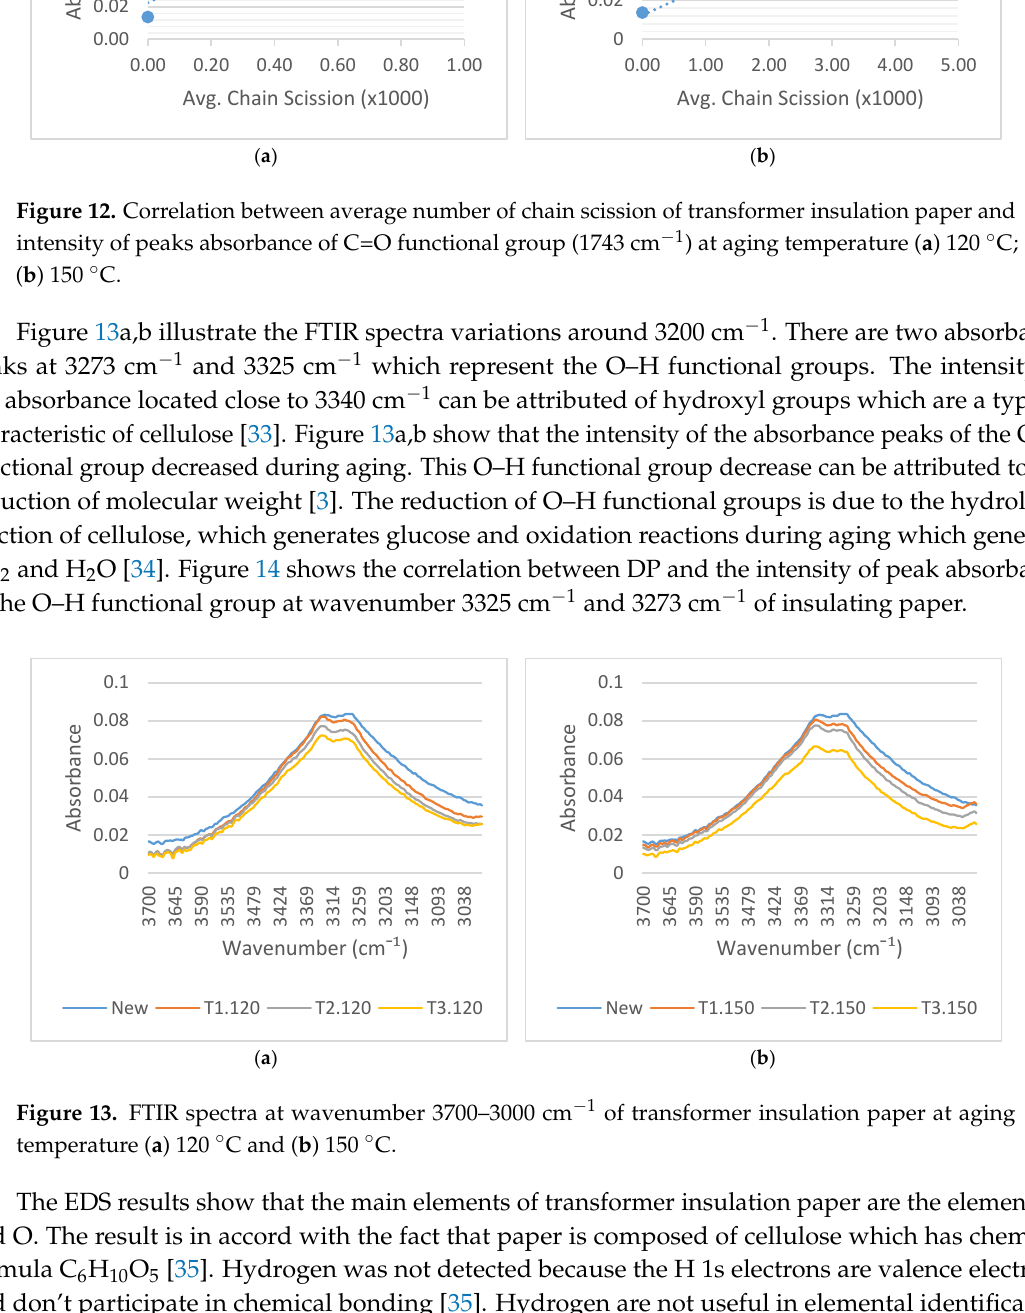
Figure 11. FTIR spectra at wavenumber 1500–900 cm −1 of transformer insulation paper at aging temperature ( a ) 120 °C and ( b ) 150 °C.